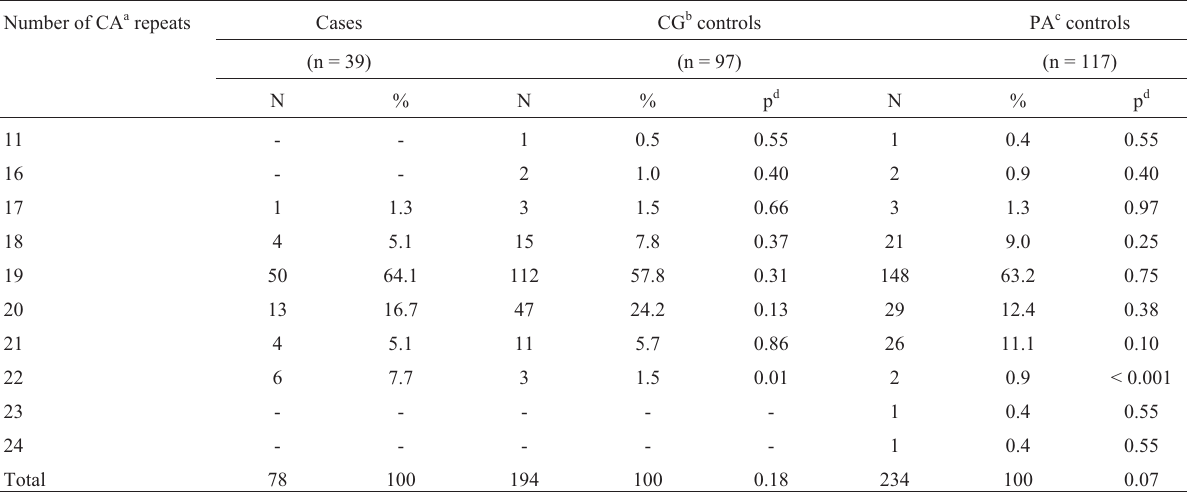
Table 1 - Frequency of IGF1 (CA)n polymorphism in cases and controls. Number of CA a repeats